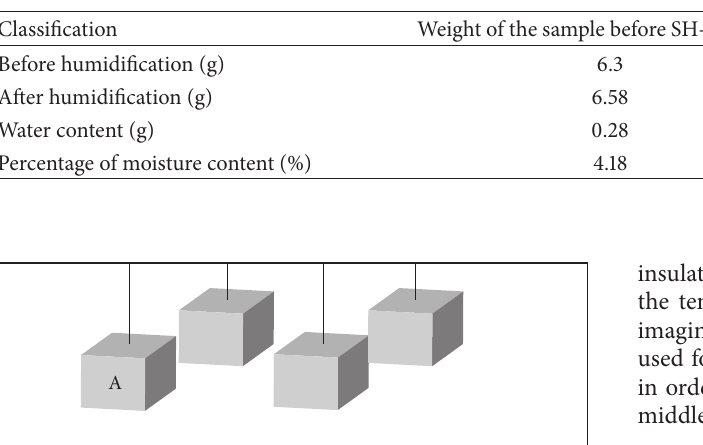
Table 1: Moisture absorption amount of mineral wool before and after SH-AF treatment.